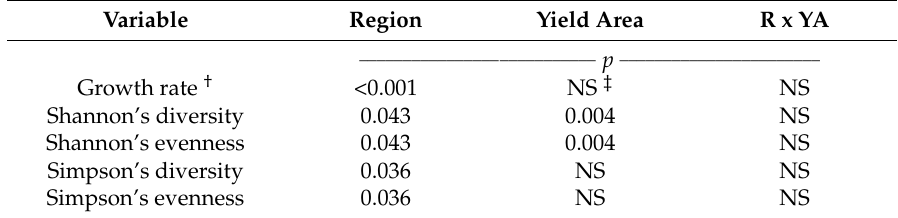
Table 4. Analysis of variance summary of the effects of region (i.e., 1 through 7 of Arkansas’ “Grow for the Green” yield contest), yield area (i.e., high- and average-yield), and their interaction on microbiological growth rate and Shannon’s and Simpson’s diversities measured on EcoPlates TM [4] averaged across years (2014 and 2015).